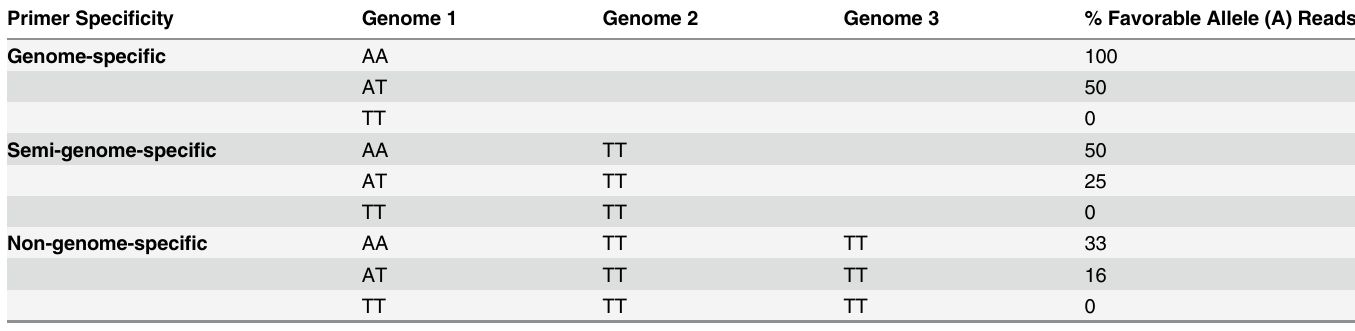
The wild type SNP allele in this example is